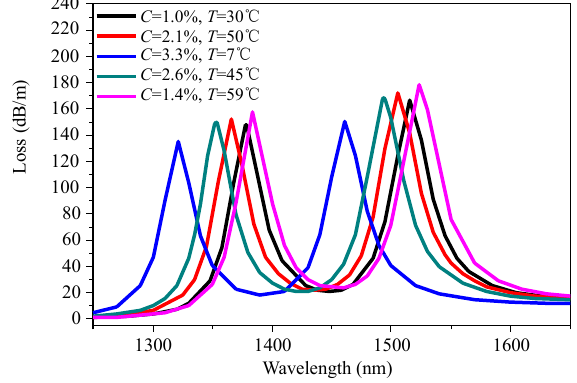
Fig. 10 Loss spectra under five different environmental conditions. Table 5 Wavelength-shifts with different conditions (States Ⅰ , Ⅱ , Ⅲ , Ⅳ , and Ⅴ) a s an example.